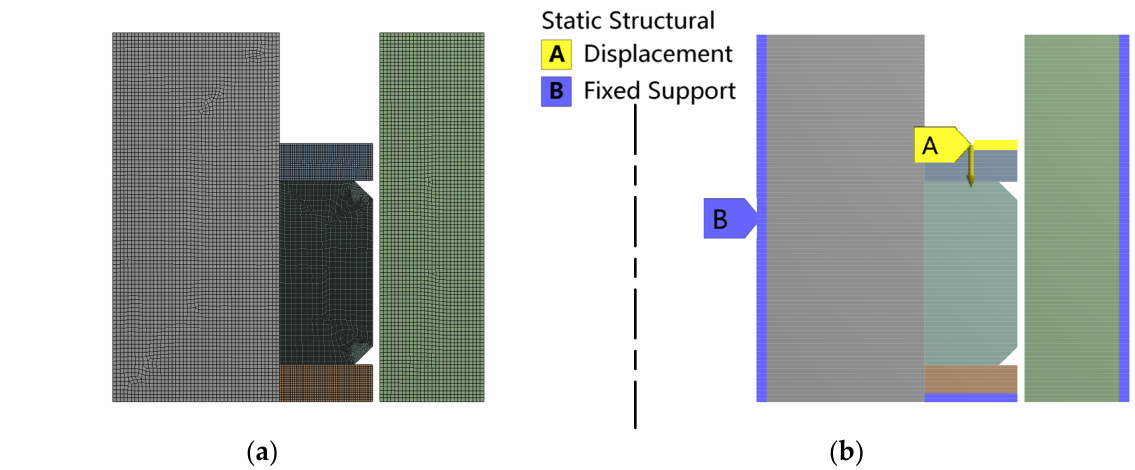
Figure 3. Diagram of simulation process. ( a ) Diagram of grid division; ( b ) Diagram of constraints.